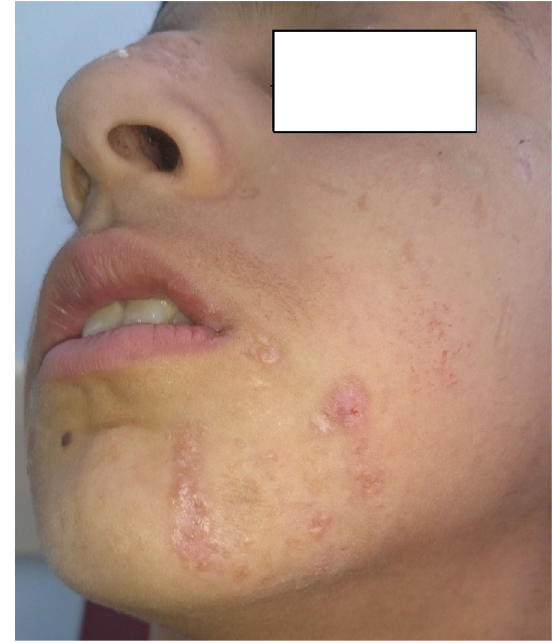
Figure 3. Yellowish-brown, slightly elevated papular lesions located in the left cheek after